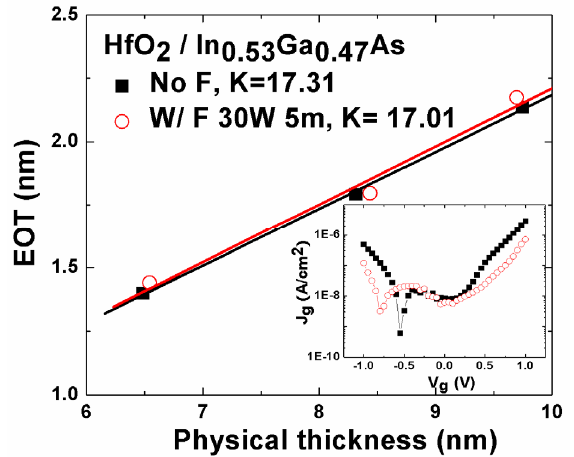
Figure 5. Equivalent oxide thickness (EOT) versus physical thickness for the samples with and without F incorporation. Inset: the gate leakage current comparison of samples with and without F